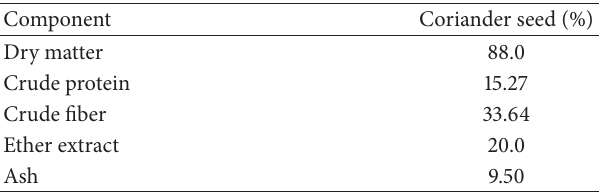
Table 2: Nutritional composition of coriander seed